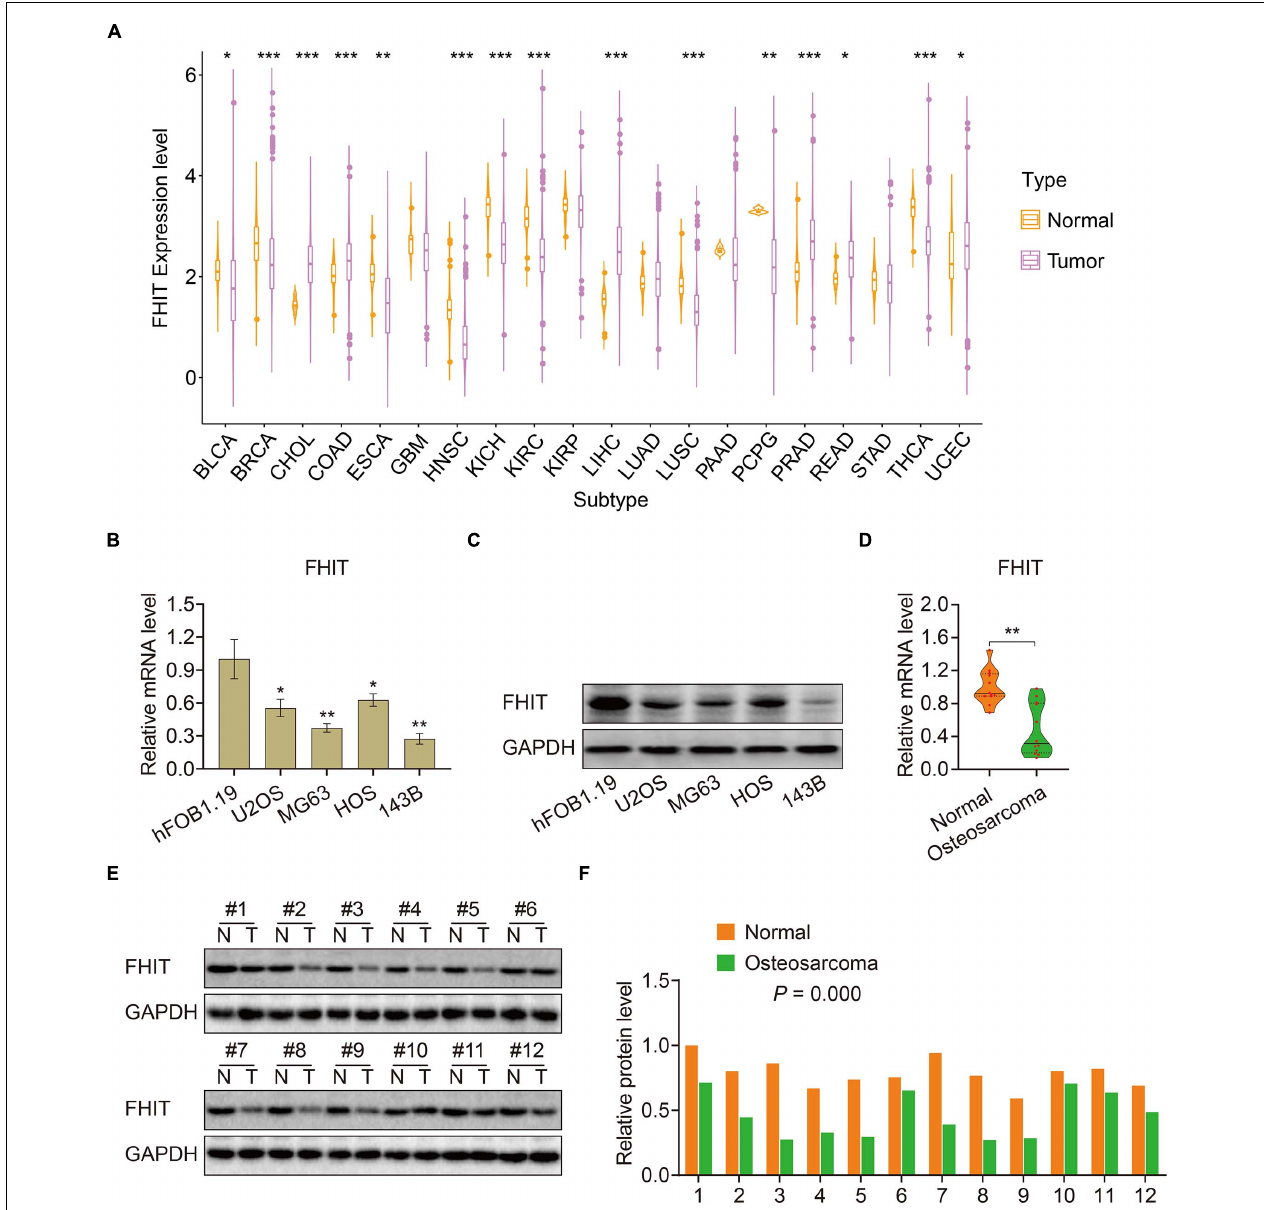
FIGURE 8 | FHIT expression in osteosarcoma cells, tumor tissues, and other malignant tumors. (A) FHIT expression in other malignant tumors and adjacent normal tissues. (B,C) qRT-PCR and western blotting were performed to detect mRNA and protein expression of FHIT in osteosarcoma cells and normal osteoblasts. (D,E) mRNA and protein levels of FHIT were explored by qRT-PCR and western blotting. (F) Quantitative analysis of the western blot results. * P < 0.05, ** P < 0.01, *** P <